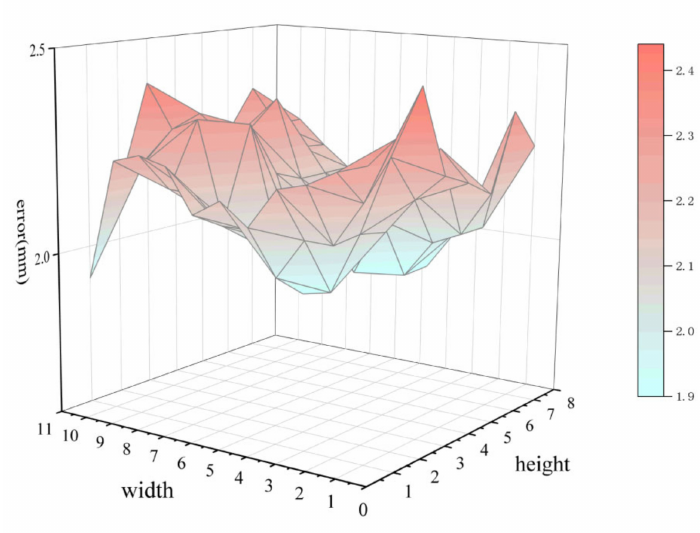
Figure 10. Visualization of positioning errors at z = 400 mm.